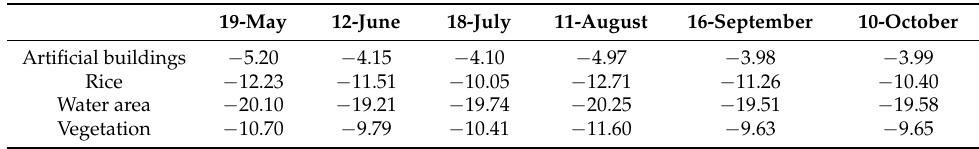
Table 5. VV polarization backscatter coefficient of ground objects.